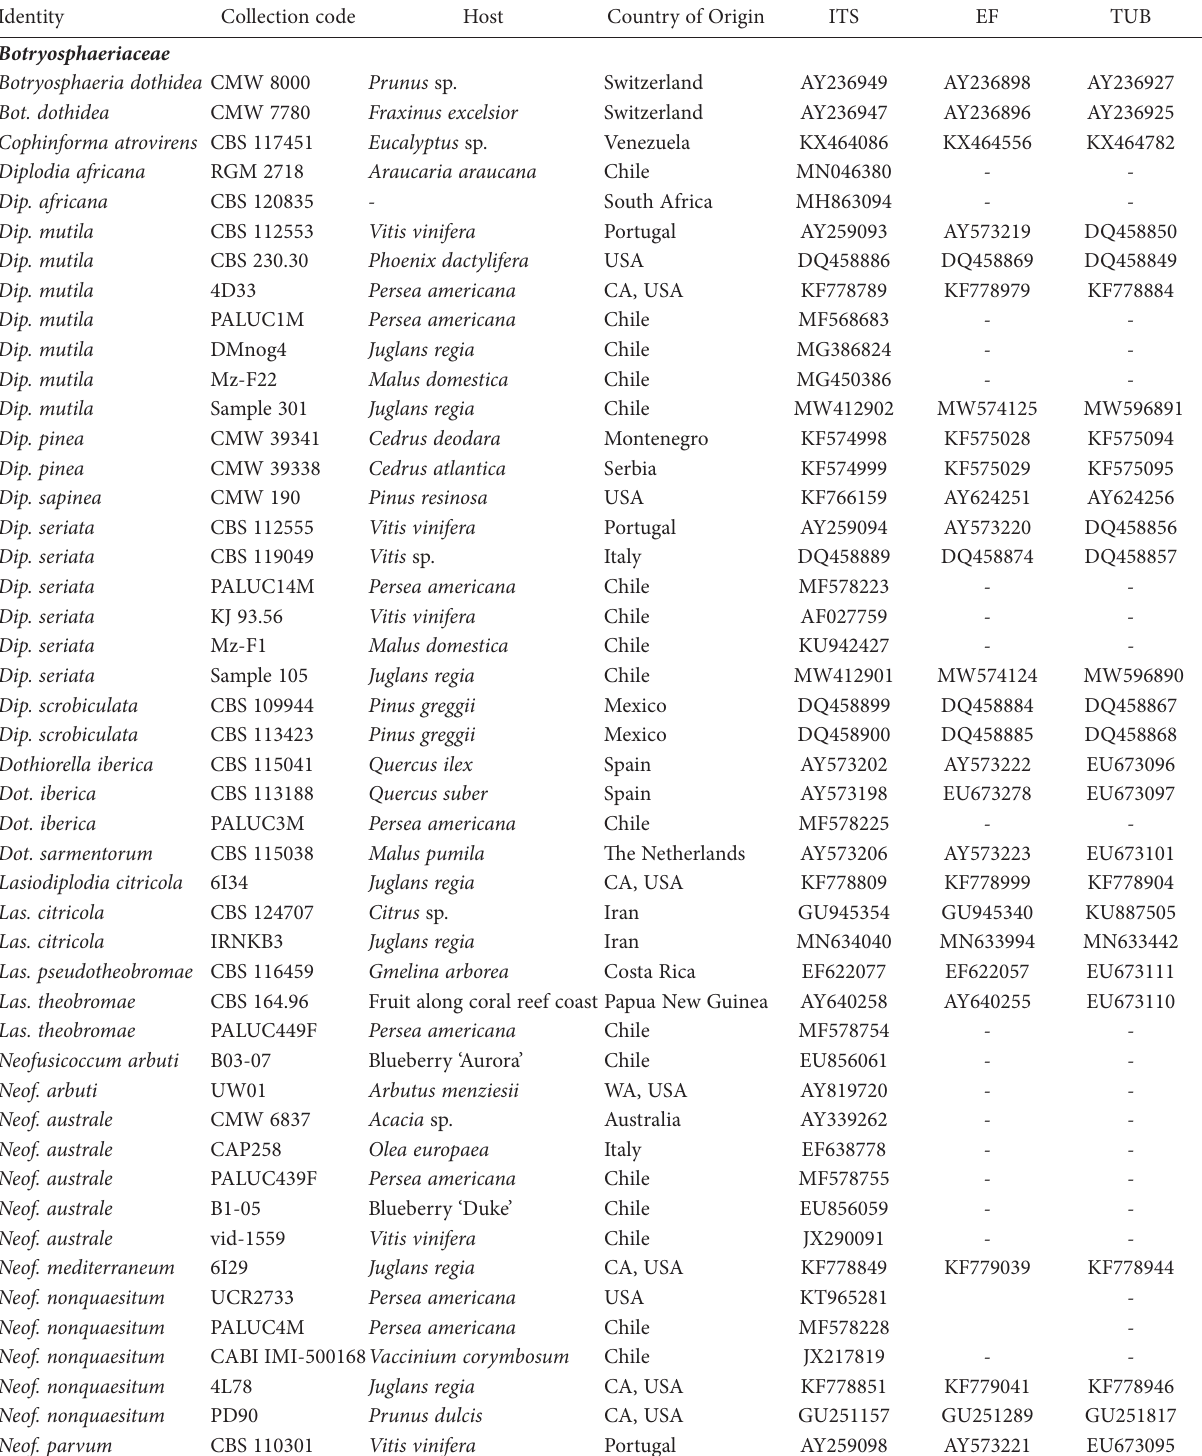
Table 1. GenBank accession numbers, hosts and species identity for all Botryosphaeriaceae and Diaporthaceae taxa used for phylogenetic